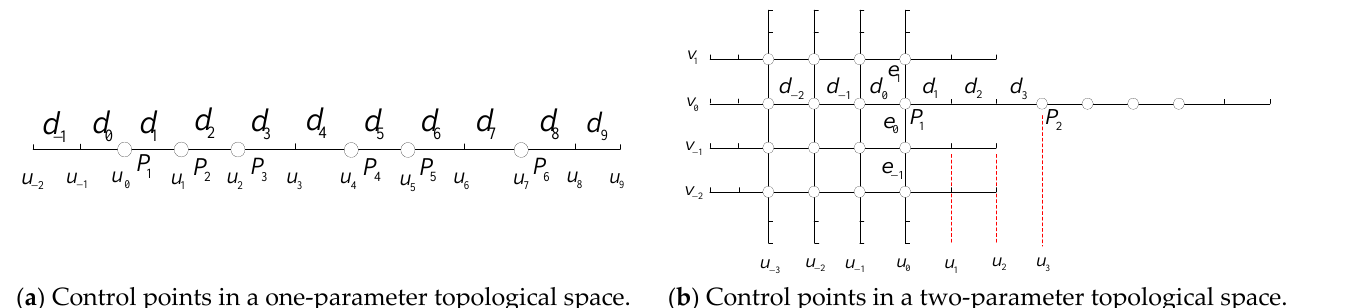
( b ) Control points in a two-parameter topological space. Figure 5. Control points in I-meshes. Figure 5. Control points in